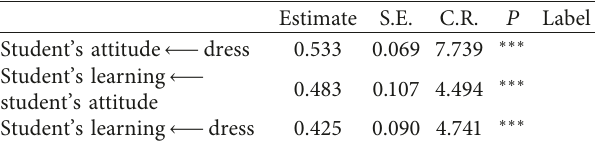
Figure 2: Standardized estimates. Table 5: Summary of hypothesis testing results. Estimate S.E.